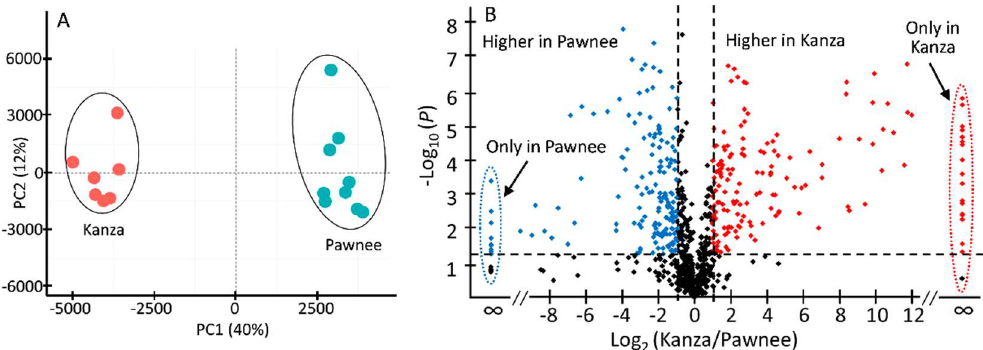
Figure 2. Principal component analysis (PCA) scores plot ( A ) and volcano plot ( B ) of all Kanza and Pawnee samples. The PCA scores plot shows a clear segregation of Kanza and Pawnee samples, indicating that Kanza and Pawnee have different metabolic profiles. A volcano plot of mass features (relative abundance >1) was constructed with x -axis presenting fold change (logarithms of Kanza-to-Pawnee ratios) and y -axis significance level (logarithms of p value). The plot shows the metabolites that were significantly higher in Kanza (upper right corner, red color) and in Pawnee (upper left corner, blue color). Two vertical dotted lines denote the boundary of two-fold change (Kanza relative to Pawnee, Log 2 (0.5) = − 1, Log 2 (2) = 1) and the horizontal dotted line specifies the statistical significance cutoff (−Log (0.05) = 1.30).